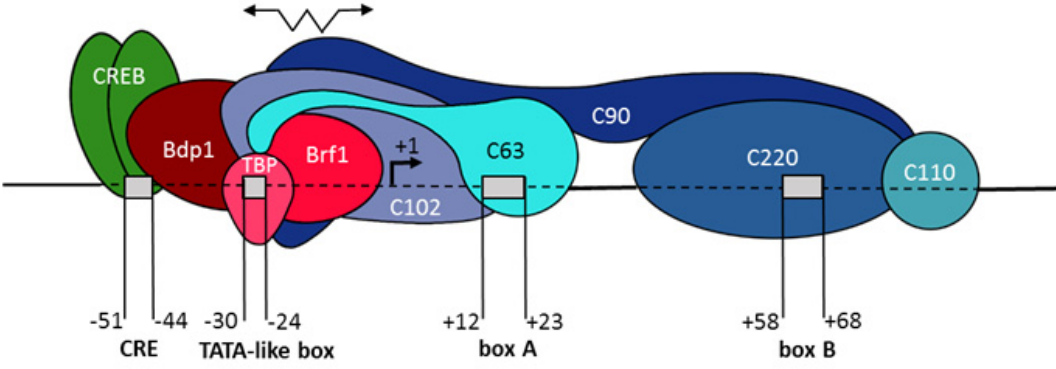
Figure 13. A complex of TFIIIB, TFIIIC, and CREB with a gene carrying a type 2 promoter for pol III. Factor binding sites in the gene and its 5 ′ -FS are shown as boxes. The subunits of TFIIIB and TFIIIC are colored in different shades of red and blue, respectively. The transcription start site is marked as +1. The vertebrate tRNA genes and SINEs lack specific TATA-like boxes and CRE sites, but otherwise have a structure similar to that shown in the diagram. The zigzag arrow symbolizes the ability of the C63 and C102 subunits to stretch, which allows TFIIIB to bind to a more distant site in the 5 ′ -FS of a SINE copy in case of high GC content at –31/–24. The scheme is based on a model for the interaction of TFIIIB and TFIIIC subunits with human tRNA genes (modified from [9] with permisson). Supplementary Materials: Supplementary materials can be found at www.mdpi.com/xxx/s1.